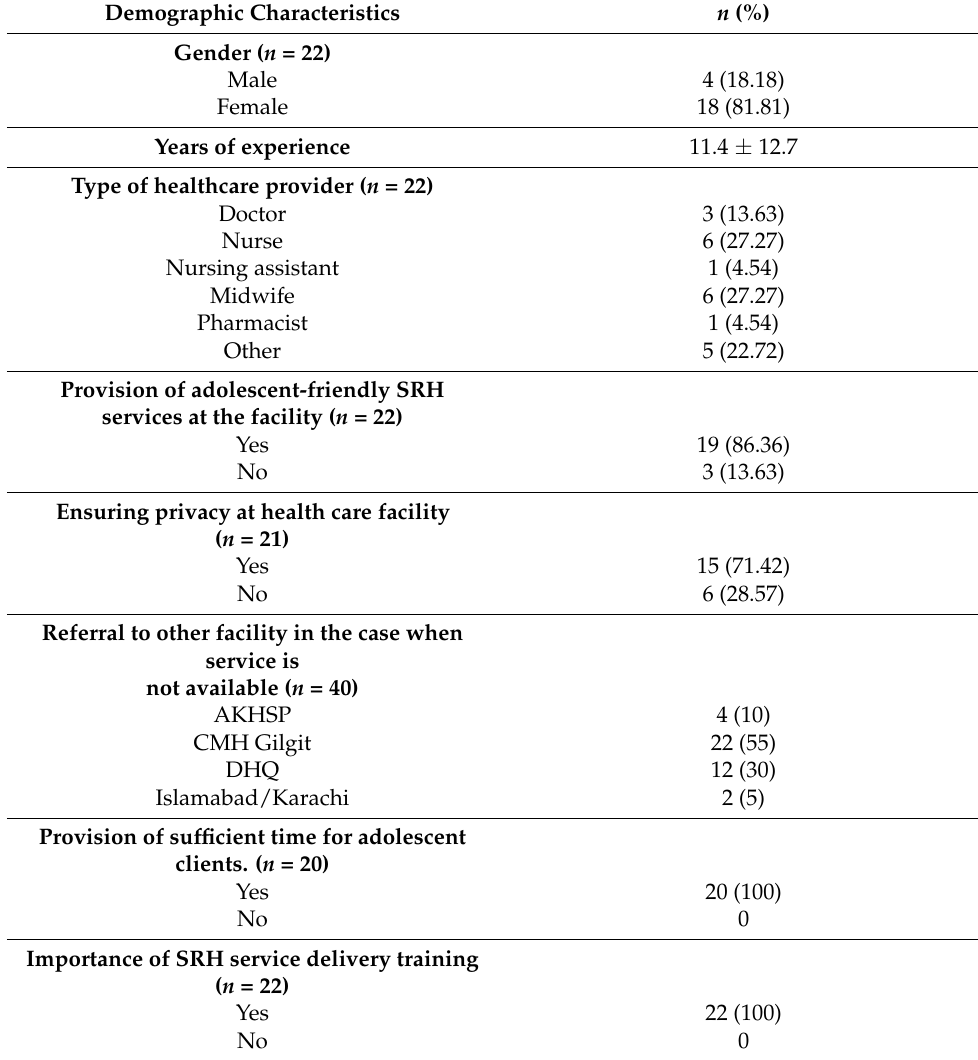
Table 2. Healthcare providers Demographic characteristics ( n =